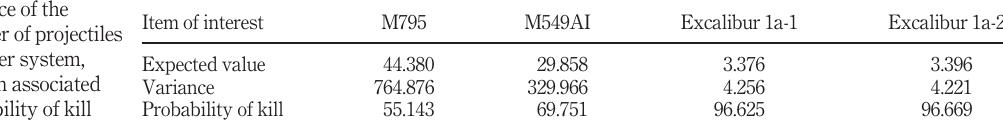
Figure 2. Expected number of projectiles required per munition type